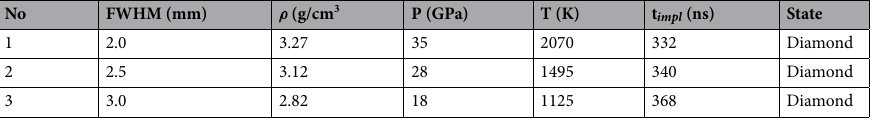
Table 11. Achieved physical conditions in compressed carbon using bunch intensity = 5 × 10 10 uranium ions, bunch length = 200 ns, particle energy = 2 GeV/u, initial sample radius, R si = 300 μm, sample mass = 6.4 mg/ cm.